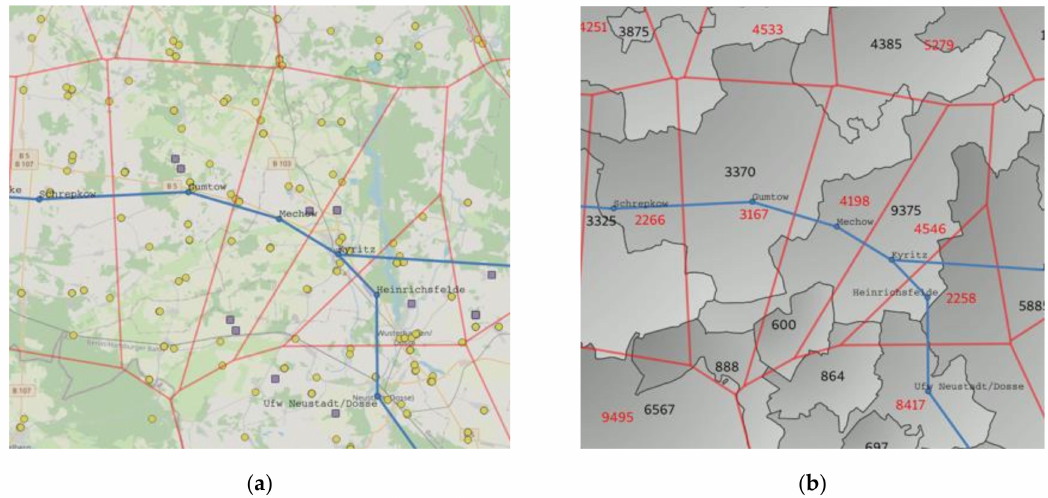
Figure 1. Catchment area (red polygons)-based plant and inhabitant allocation to distribution system operator (DSO) substations; ( a ) allocation of PV (yellow dots) and battery storage system units (purple squares); ( b ) determination of the number of inhabitants per DSO substation (red